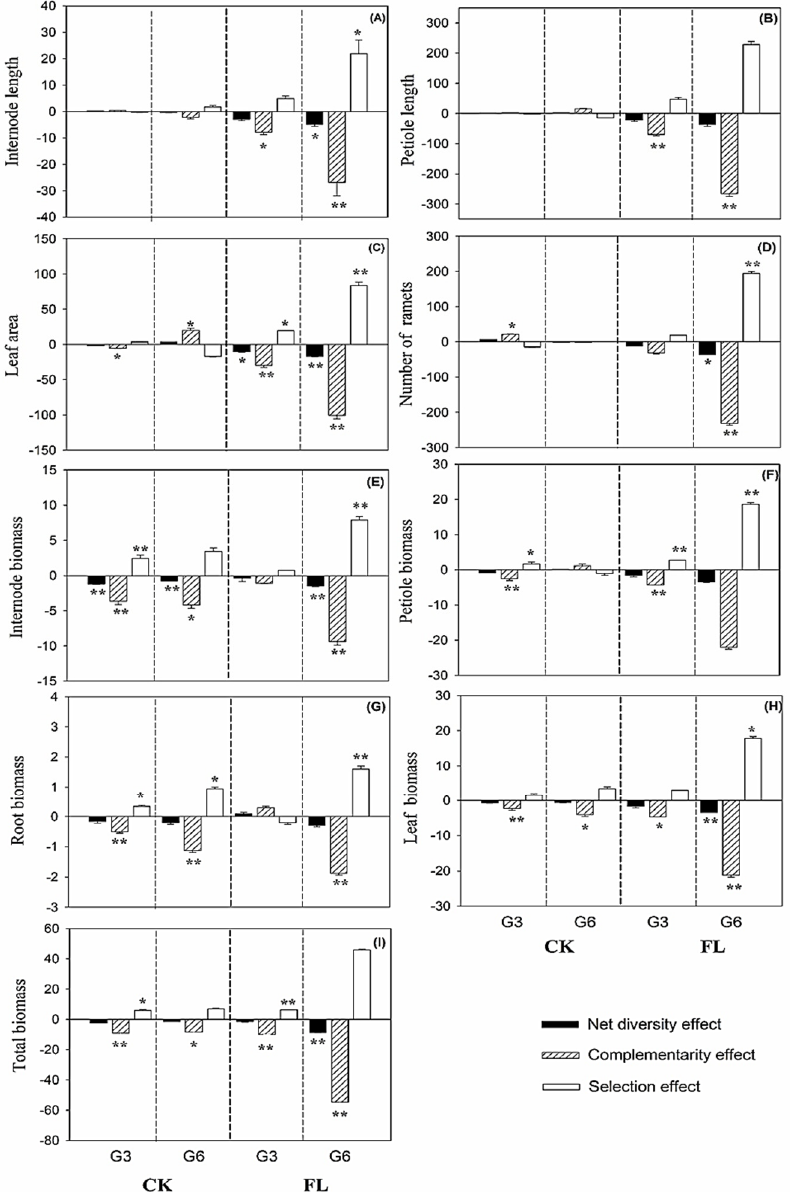
Figure 4. Genotypic diversity net effect value, complementarity and selection effect value of growth traits ( A ) Internode length, ( B ) Petiole length, ( C ) Leaf area, ( D ) Number of plants, ( E ) Internode biomass, ( F ) Petiole biomass, ( G ) Root biomass, ( H ) Leaf biomass and ( I ) Total biomass of H. vulgaris . Asterisks *, and **, indicate significance at p ≤ 0.05, and p ≤ 0.01,